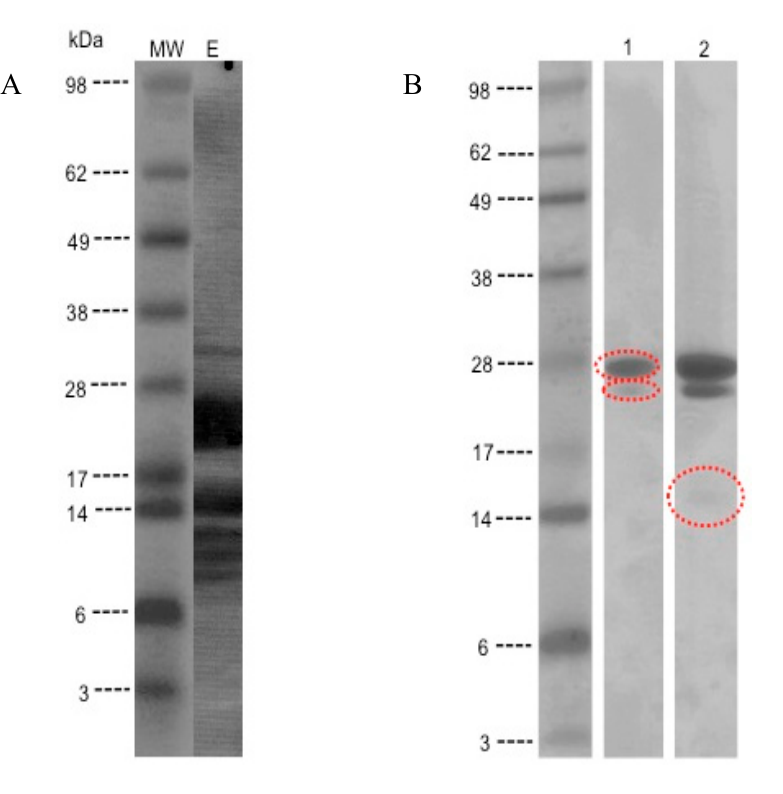
Figure 1. SDS-PAGE analysis for kiwi protein extract. (A) MW: Molecular weight standard and E: Kiwi extract. (B) Two lanes (1 and 2) of the gel which was sent to the sequencing facility for MS/MS analysis and identification of the proteins IgE-binding bands were identified at 80, 62, 40, 28, 24, 15, and 6 kDa by immunoblotting using patients’ sera. Fifteen out of 17 children tested (88%) had IgE antibodies that recognized the 28 kDa (Act d 1) and 24 kDa (Act d 2) proteins; two children (12%) had IgE that recognized a protein of 15 kDa (kiwellin) (Figure